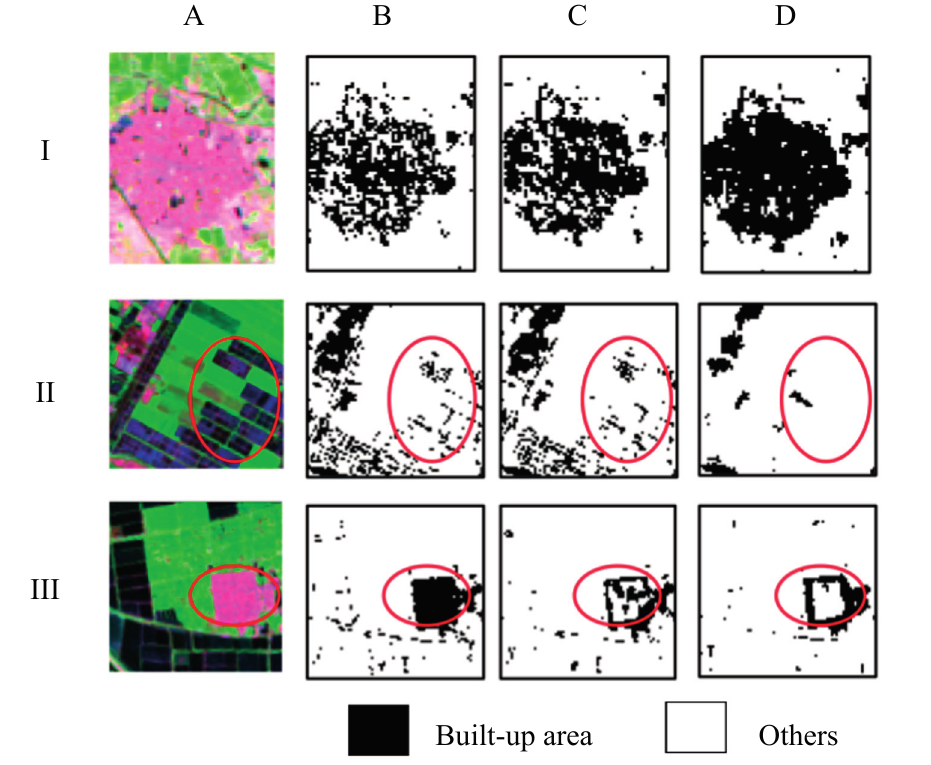
Figure 9. Portions of Landsat TM images (Bands 7, 4 and 2 as R, G and B) ( A ); I-A: built-up area (mostly in the middle) and surrounding farmland; II-A: farmland and water area (blue color areas); III-A: harvested farmland (red color, in the middle) and vegetated farmland. Corresponding classification results using different data combinations in Tianjin area. ( B ) Spectral data alone; ( C ) spectral data and GLCM texture; ( D ) spectral data and multivariate variogram texture with spectral angle